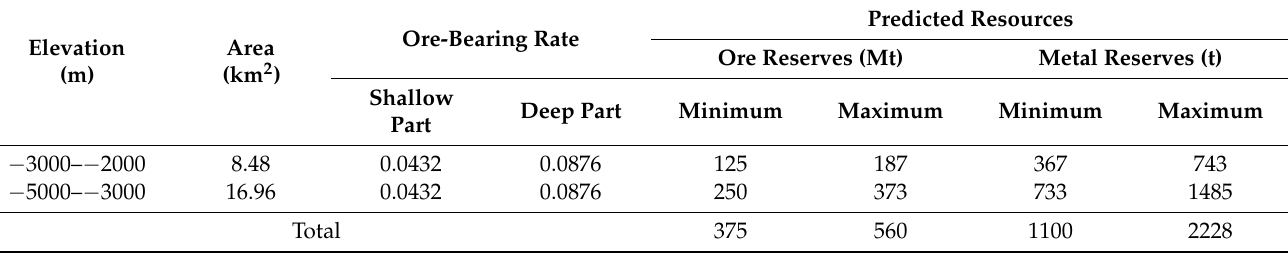
Table 7. Statistics of predicted resources in the Sanshandao